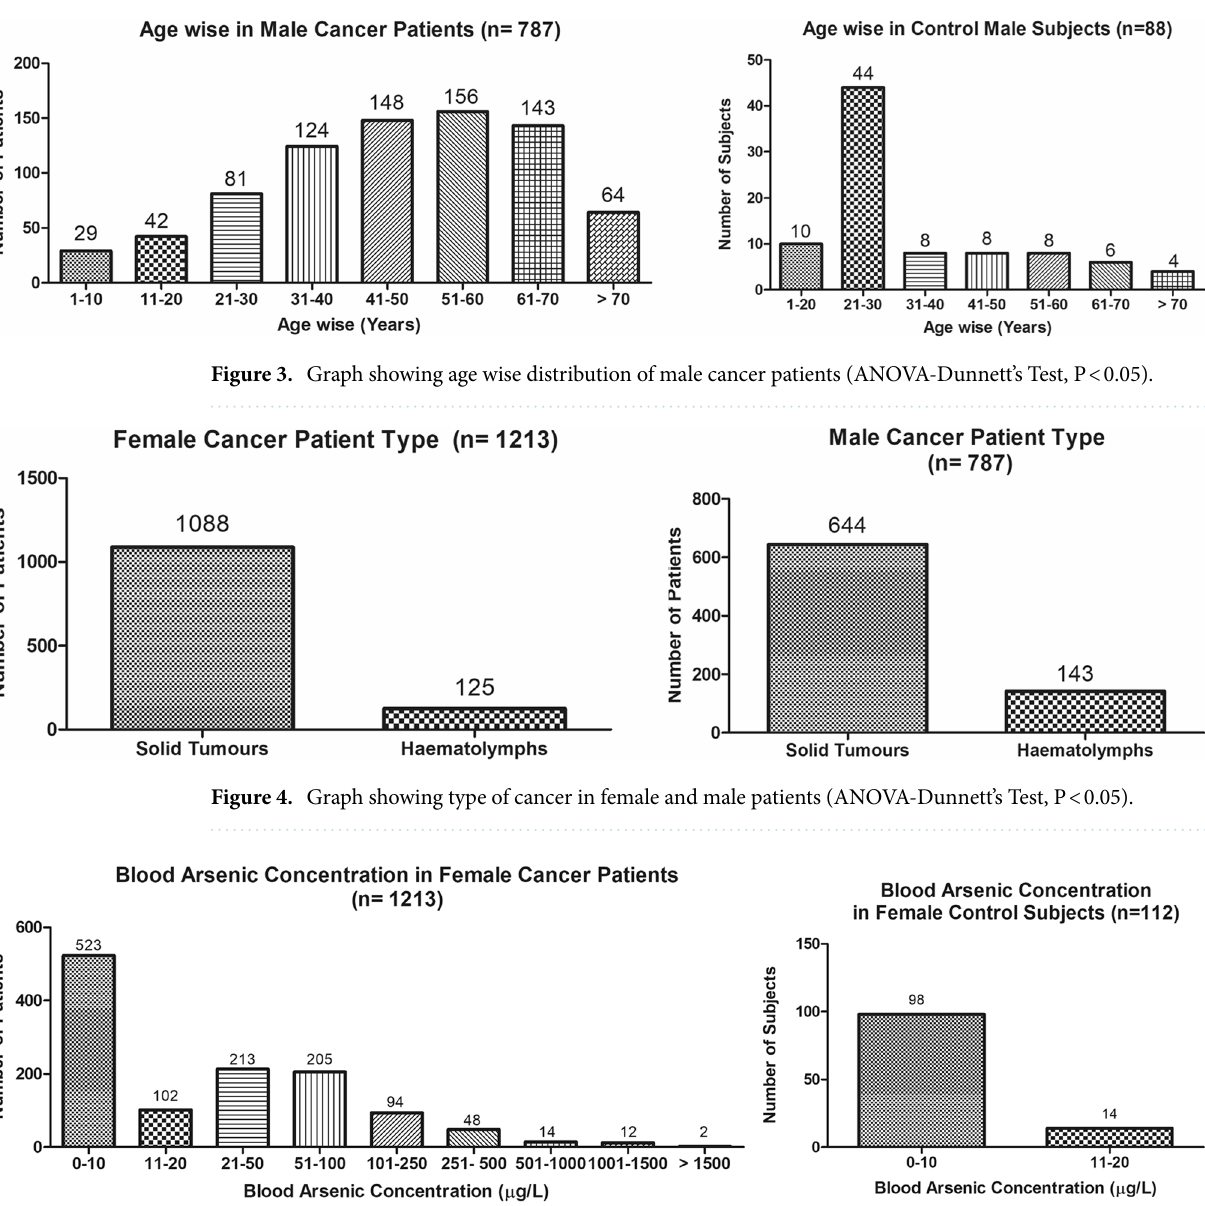
Figure 5. Arsenic concentration in blood samples of female patients were analyzed through GF-AAS (ANOVA- Dunnett’s Test, P <